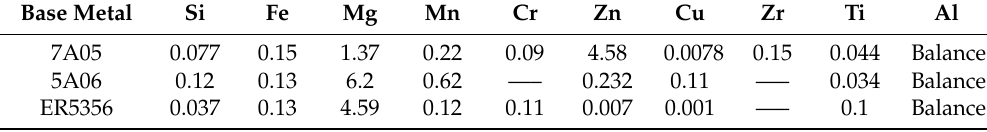
Table 1. Chemical composition (wt. %) of the 7A05 and 5A06 base metal and ER5356 welding wire.